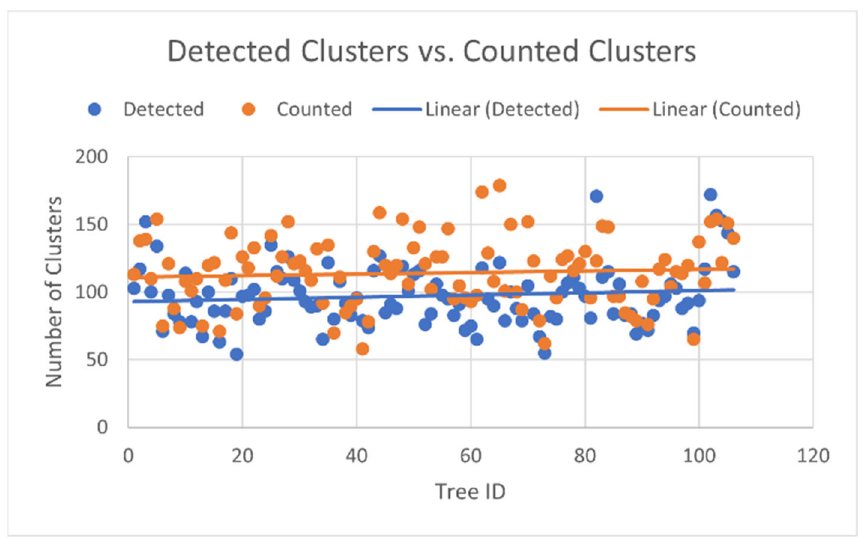
Figure 12. Comparison of all 106 trees surveyed. Note that the regression lines simply illustrate the average detected vs. counted clusters, and helps show the under ‐ detected number of clusters. In reality, there is no generally increasing trend with increasing tree ID.